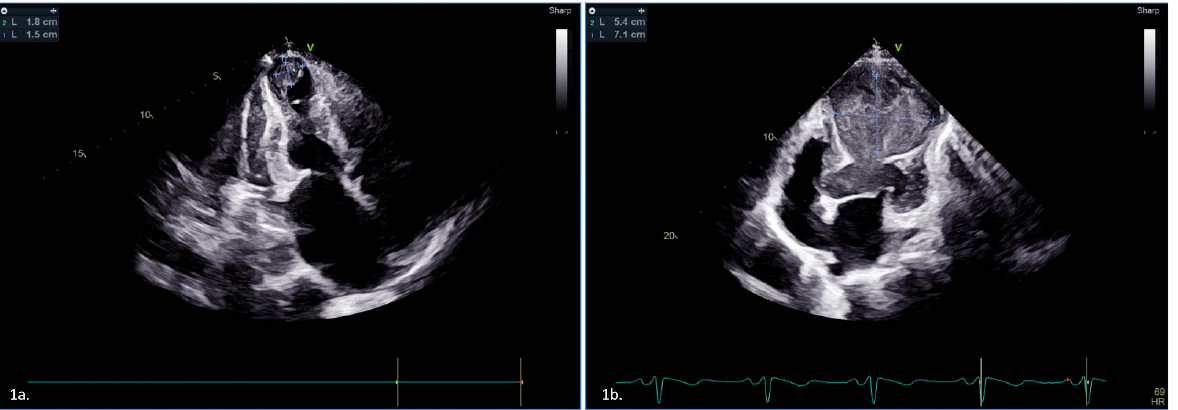
Figure 1. Echocardiographic demonstration of thrombus in two cases managed by different anticoagulation regimens. ( 1a) —two ‐ dimensional echocardiography in apical view showing homogenous echo dense mass (1.8 × 1.5 cm) at apex of left ventricle, suggestive of thrombus. ( 1b )—two ‐ dimensional echocardiography in apical view showing large echo dense mass (5.4 × 7.1 cm) at apex of a dilated and akinetic left ventricle, suggestive of thrombus.